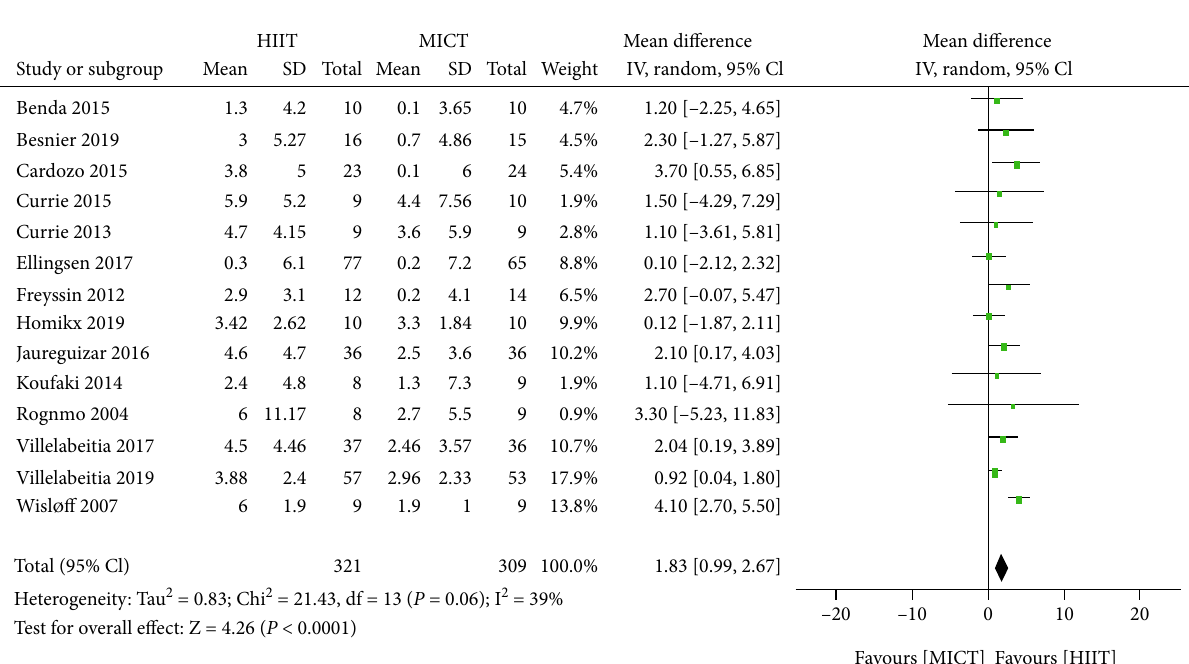
for patients with CAD and HF. HIIT: high-intensity interval training; 2 : peak oxygen consumption; CAD: coronary artery disease; HF: heart failure; SD: 2 patients; mean di ff erence of 0.41 mL/kg/min, 95% CI 0.88